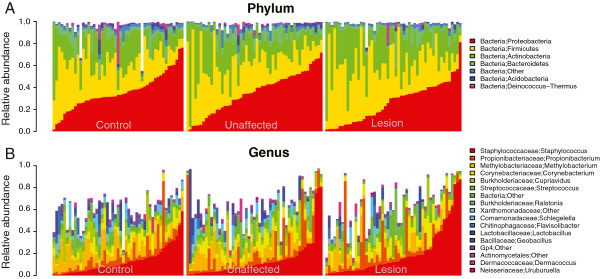
Taxonomical composition of cutaneous microbiota shown by skyline plots. (A) phylum, (B) genus levels. Predominant taxa are shown. White areas reflect specific taxa not graphed.